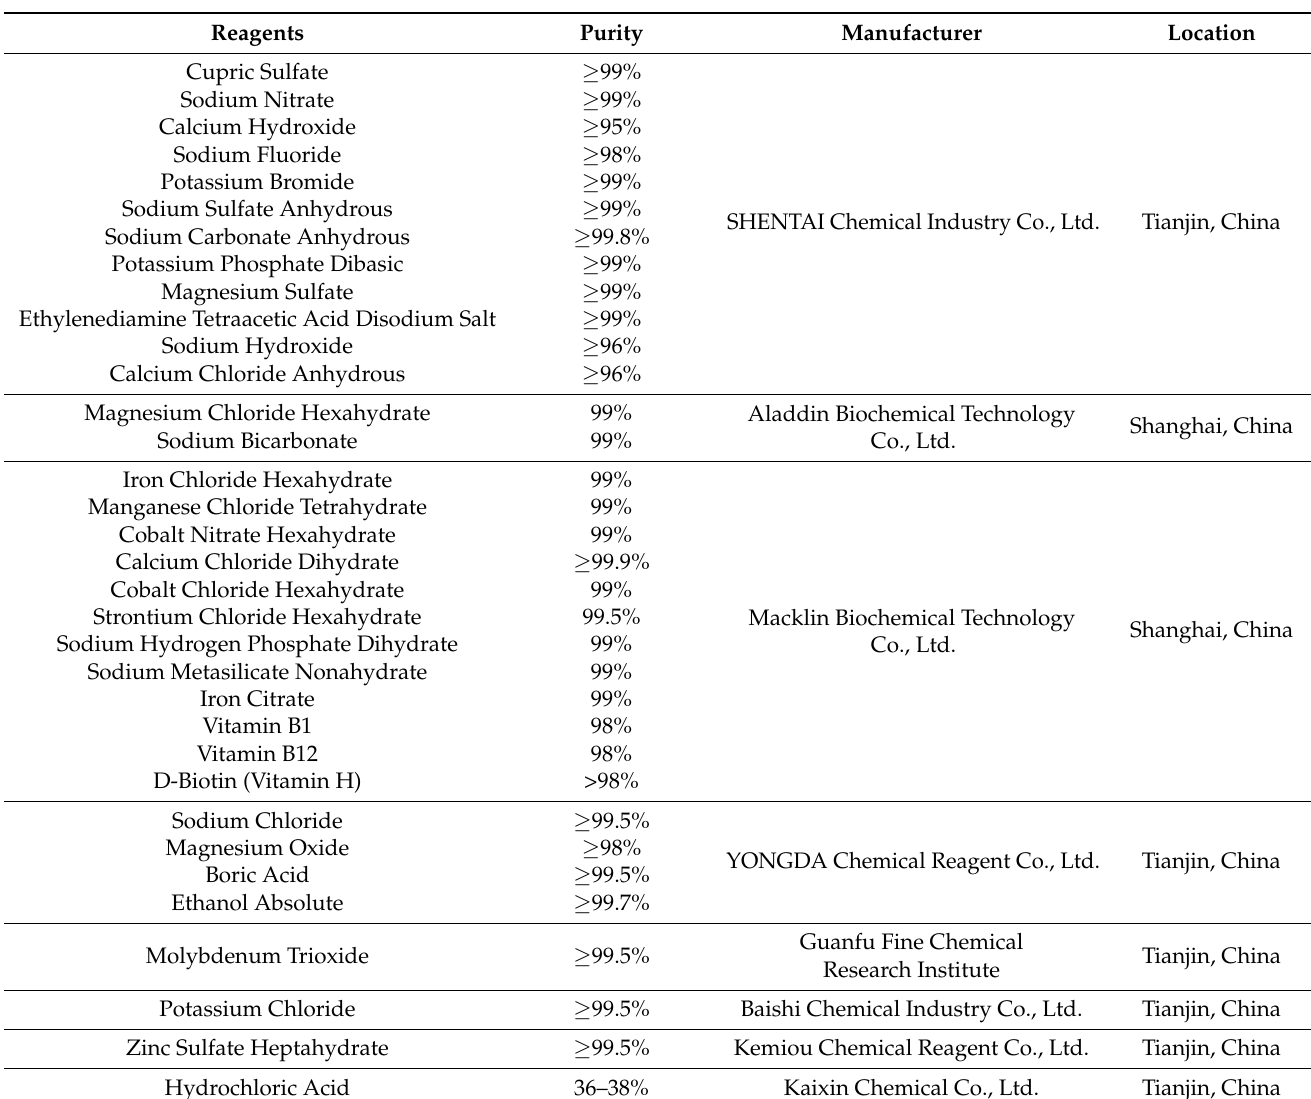
Table 3. Chemical reagents used for this